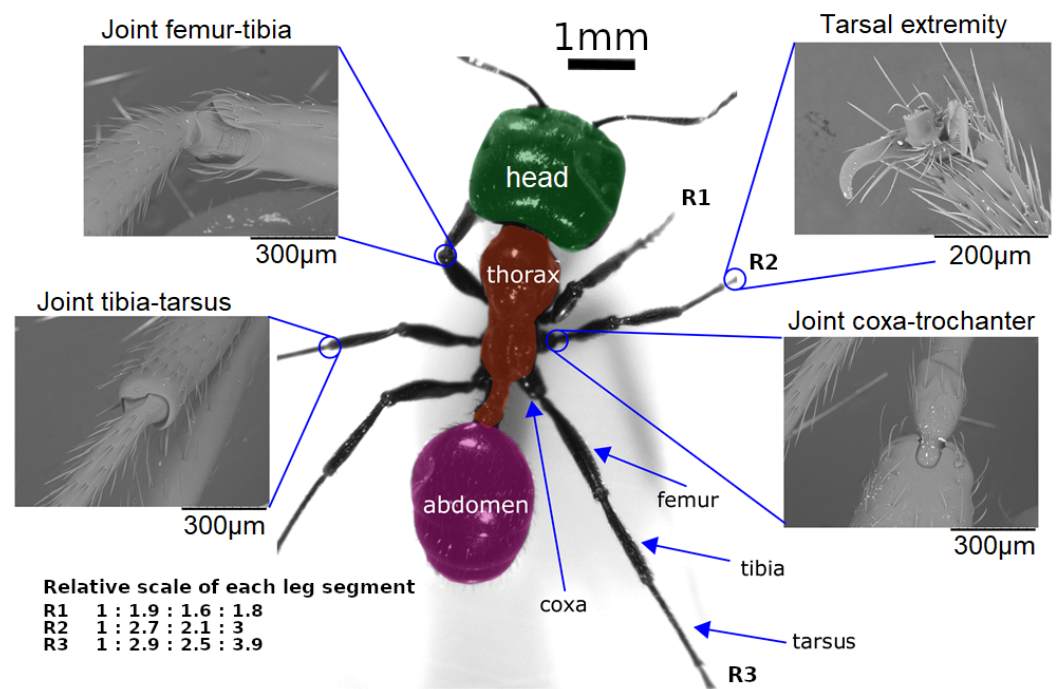
Figure 3. Scale, segments, and joints in ant Messor barbarus . Photographic credits: Hugo Merienne, Centre de Recherches sur la Cognition Animale (CRCA UMR 5169), Toulouse, France. The relative scale of each segment (coxa, femur, tibia, tarsus) w.r.t. the coxa leg of each leg (R1, R2, R3) comes from [73]. Adapted from [82] under CC-BY License,